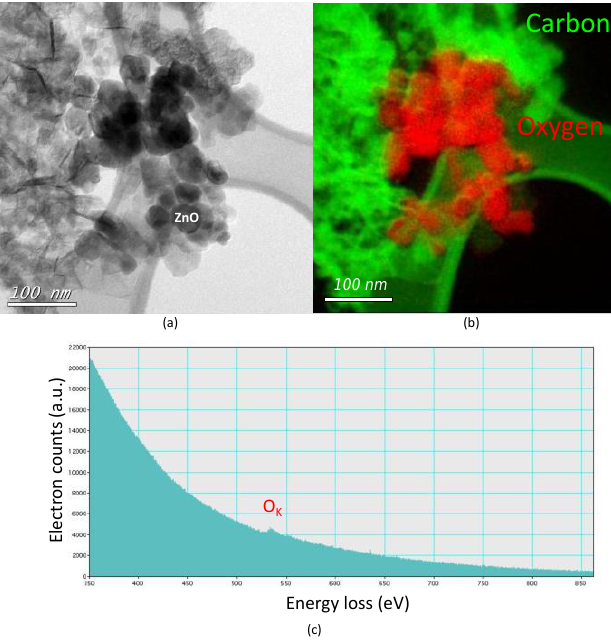
Figure 7. Characterization of the GrZnO sample: ( a ) bright-field TEM image—scale bar 100 nm; ( b ) dark-field TEM image for the same area as in ( a ) with electron energy loss spectroscopy (EELS) spectral imaging showing the presence of carbon (green) and oxygen (red) and ( c ) representative EELS profile.